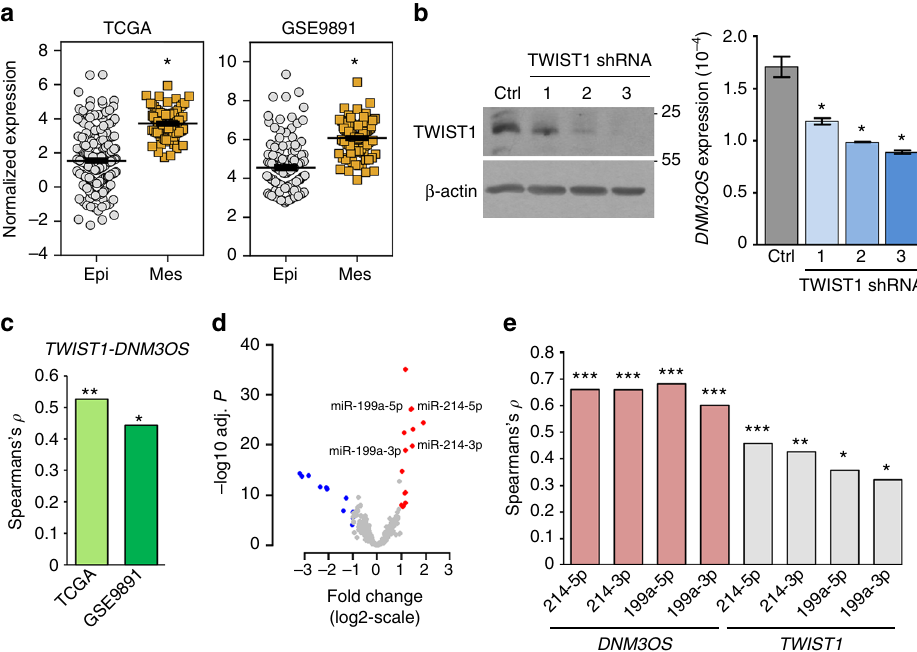
Fig. 7 TWIST1 regulates DNM3OS expression in ovarian cancer cells . a Expression of TWIST1 in mesenchymal (Mes; n = 89 for TCGA and n = 97 for GSE9891) subtype compared with the epithelial (Epi; n = 231 for TCGA and n = 136 for GSE9891) subtype in two independent patient cohorts. BH adjusted * P < 10 − 19 ; determined by edgeR for TCGA and two-tailed t -test for GSE9891; mean ± SEM. b SKOV3 ovarian cancer cells expressing one of three TWIST1 shRNA or control non-targeting shRNA were Western blotted and DNM3OS levels were evaluated by qRT-PCR (data presented are one of two independent experiments performed); error bars are ± SEM * P < 0.008; two tailed t -test. c Spearman ’ s correlation coef fi cient ( y -axis) between TWIST1 and DNM3OS expression in two data sets ( x -axis); * P = 4.16 × 10 − 13 , ** P < 2.2 × 10 − 16 . d Volcano plot of miRNA in TCGA mesenchymal subtype compared with epithelial subtype that are at least twofold upregulated (red dots) or downregulated (blue dots). Gray dots represent remaining miRNA. miRNA in the miR-199/-214 cluster are labeled. X -axis is miRNA expression fold-change, and Y -axis is differential expression P -values determined by edgeR. e Expression correlation between DNM3OS and miRNA or TWIST1 and miRNA in TCGA cohort. X -axis represents DNM3OS or TWIST1 and indicated miRNA pair. Y -axis represents Spearman ’ s rank correlation coef fi cient (Spearman ’ s ρ ) for each pair. * P < 3.6 × 10 − 09 ; ** P = 1.41 × 10 − 15 ; *** P < 2.2 × 10 − Detection of conserved lncRNA . A sliding window of 200 nucleotides was chosen puromycin selection, cells were lysed as indicated above. Proteins were subjected to along the lncRNA transcript and conservation levels were measured using the SDS-PAGE, transferred to nitrocellulose, and Western blotted with the following average phastCons score across the primate species. The maximally conserved 200 antibodies: E-CADHERIN, N-CADHERIN, SNAIL, and SLUG (1:1000; Cell Sig- nucleotides sliding window was selected as the representative conservation score 53 . naling), TWIST1 (1:500; Santa Cruz), and β -ACTIN (1:2000; Sigma). Uncropped scans of the blots are in Supplementary Fig. 10. Pathway enrichment analysis . Differentially expressed genes signi fi cantly co- expressed with a speci fi c lncRNA were selected to conduct pathway enrichment analysis using the canonical KEGG pathway database 34 , which is embedded into the software WebGestalt 54 . Pathways showing signi fi cantly enriched (BH adjusted hypergeometric test P < 0.05) number of differentially expressed genes were recognized as the lncRNA associated pathways. Analysis of microarray mRNA and lncRNA expression data . Three independent microarray gene expression pro fi ling data (accession numbers GSE9891, GSE18520, and GSE26193) for ovarian cancer patients were downloaded from the GEO database 36 . The data were generated on the Affymetrix Human Genome U133 Plus 2.0 platform following standard Affymetrix protocol. The data were normalized using the robust multi-array average (RMA) algorithm 55 in the Affy package for R 56 . We mapped the probe set IDs to the NetAffx annotation fi le to extract lncRNA expression. Probes were averaged to calculate a single-expression intensity measure per gene/lncRNA per array. Differential expression was mea- sured using unpaired t -tests. lncRNA and mRNA association was established by Spearman rank correlation. siRNA, shRNA, and western blotting . Human ovarian cancer SKOV3 cell lines (mycoplasma free, authenticated) from Dr. Dineo Khabele were cultured as pre- reverse: 5 ′ -ACTCAAGGGCTGTGATTTCC-3 ′ primers. RNA sequencing pro fi les (48 h; triplicates) were generated using the Illumina TrueSeq platform. Maximum likelihood estimates of transcript read count for each sample were computed with Kallisto v0.43.0 61 . Human transcriptome fasta fi le was downloaded from Kallisto (Ensembl version GRCh38) and used to create a Kallisto index. On paired fastq fi les, for each sample, the Kallisto quanti fi cation algorithm was run to estimate transcript abundance. Using tximport the transcript level abundances were sum- marized into gene level abundances 62 . The read counts obtained from tximport with TWIST1 -speci fi c shRNA encoded lentivirus or non-targeting control 59 were imported into edgeR for differential expression analysis 51 . In edgeR, data were (obtained from Dr. Andrew Aplin, Thomas Jefferson University); 3 days after